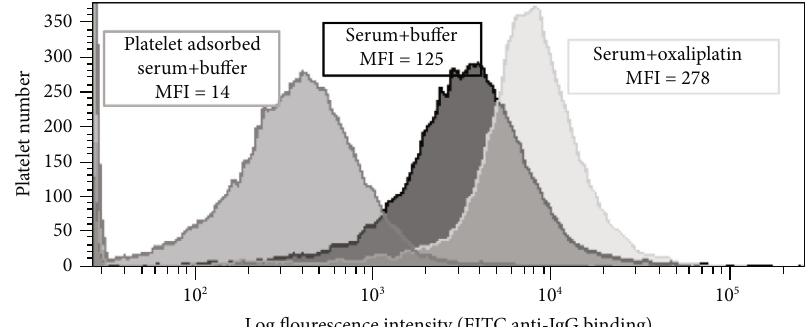
Figure 2: Detection of oxaliplatin-dependent platelet antibodies by fl ow cytometry. Platelets show high IgG binding when incubated with the patient ’ s serum in the presence of oxaliplatin (0.1mg/mL) (light gray histogram on the right) compared to platelets incubated with bu ff er/no drug present (dark histogram in the center). The numbers above each histogram are the median fl uorescence intensity (MFI)